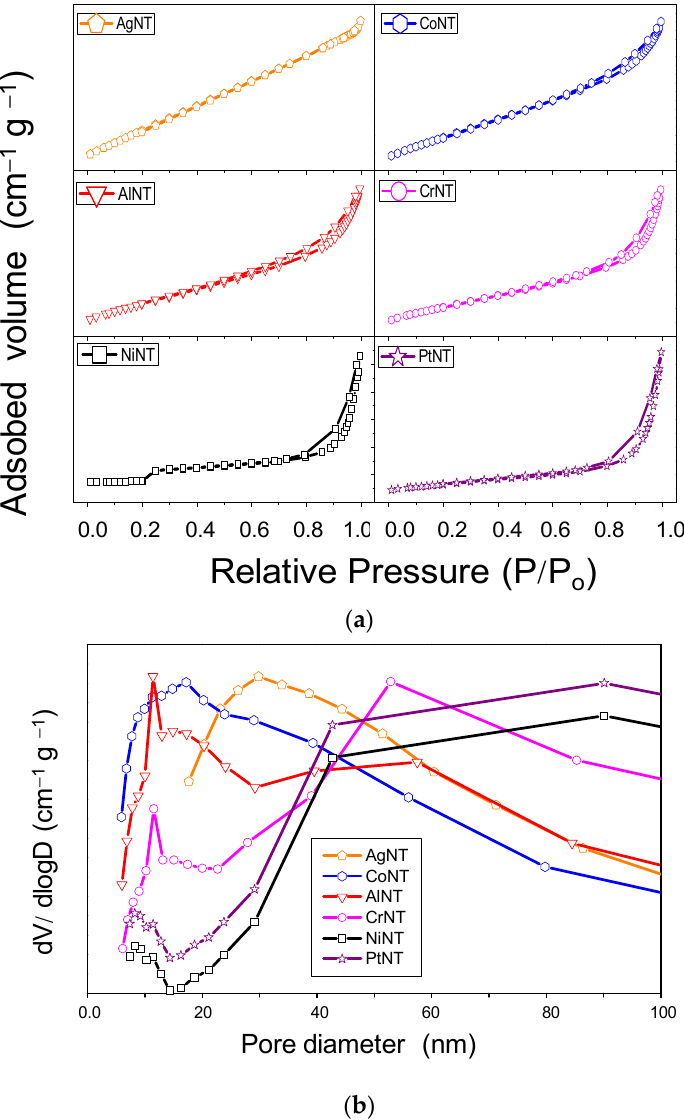
Figure 4. ( a ) N 2 adsorption-desorption isotherms and ( b ) BJH pore size distributions of the cata- lysts.